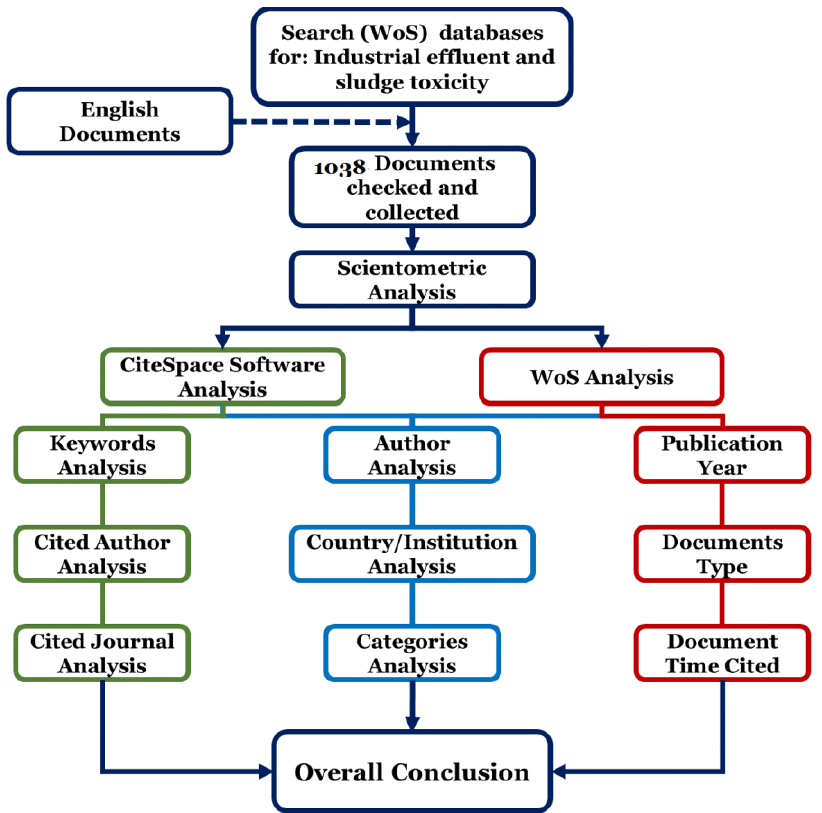
Figure 1. Research design used in the scientometric study performed for industrial effluent and sludge toxicity. To initiate this analysis’s execution, primarily, the search details, such as the pre- analyzed keywords and the English language, were inserted in the advanced search mode of WoS (shown with dark blue). Then, the obtained articles were separately analyzed via CiteSpace software (show in green), WoS analysis (shown in red), and the joint analysis of both analyzers (shown in light blue) regarding the scientometric criteria. Thereafter, conclusions were drawn based on the obtained results.